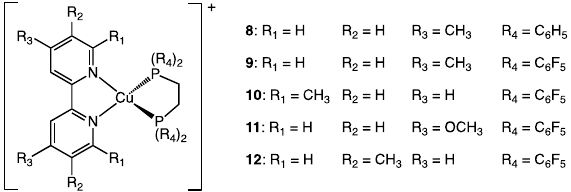
Figure 7. Structures of complexes 8–12 studied by Tsubomura and co-workers in 2015 [31]. Table 2. Reported PLQY values for powder samples for copper(I) complexes and %V bur for (NN), (PP), and (NN)(PP) units. Data are from reference [31].